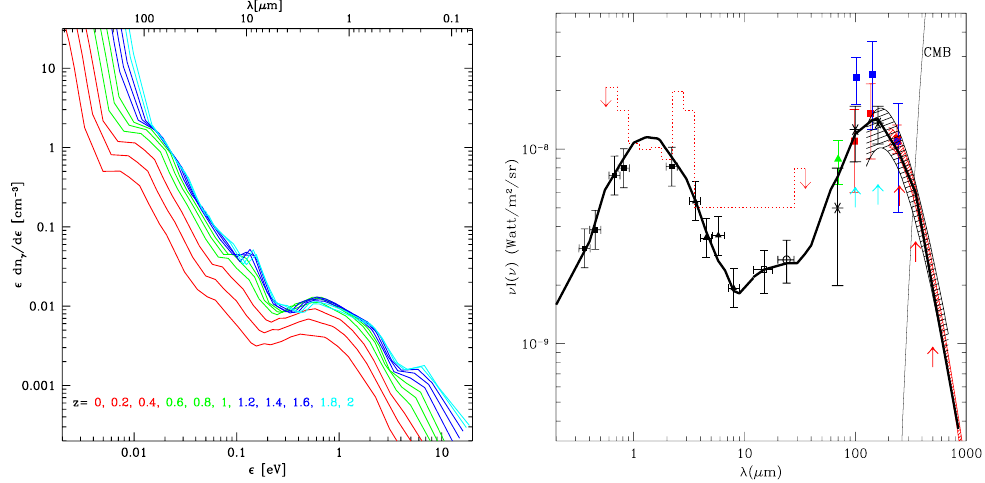
Figure 2. ( Left ): the energy-weighted proper number density of EBL photons as a function of the energy (cid:101) . The various curves correspond to different redshifts, as indicated. The contributions of CMB photons appear in the fast rise below 0.01 eV. ( Right ): the corresponding EBL spectral intensity (thick line). The data-points correspond to the integration of the known-source number counts as in Equation (2). (Taken from